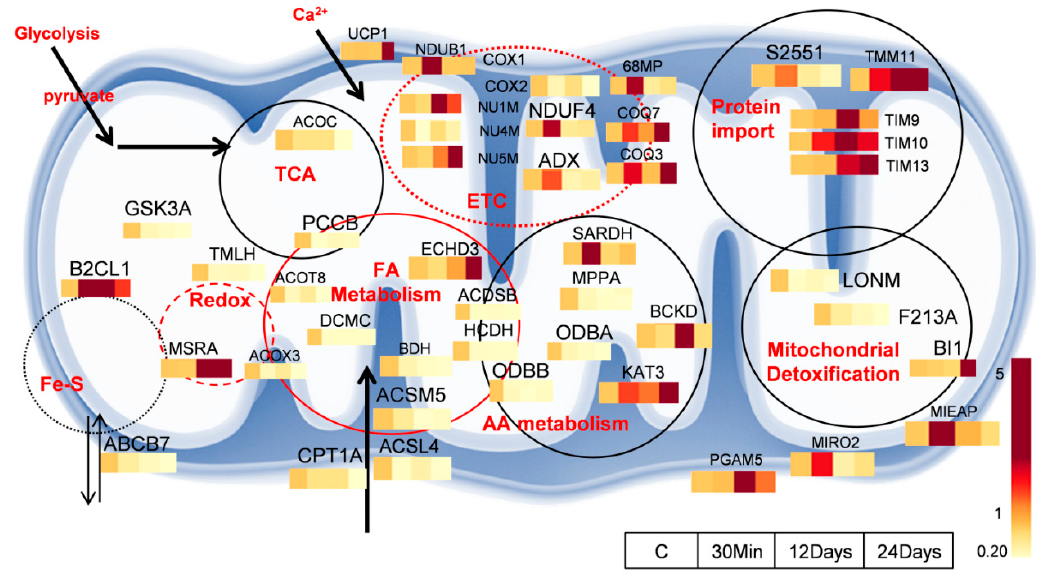
Figure 4. Overview of proteins involved in dysfunctional pathways in chronic mitochondrial complex III inhibition. Dysfunctional fatty acid metabolism, TCA cycle, and ETC can significantly decrease mitochondrial energy production. Pathways of amino acid metabolism converge closely with fatty acid metabolism to further decrease mitochondrial metabolism. Increased protein import and decreased toxic clearance of damaged proteins can ultimately lead to mitochondrial dysfunction, triggering a glycolytic switch.